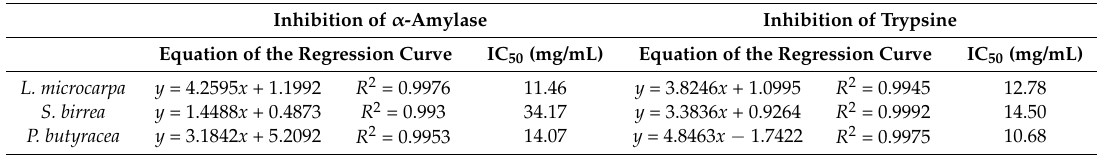
Table 6. Inhibition capacity on digestive enzymes (trypsin and α